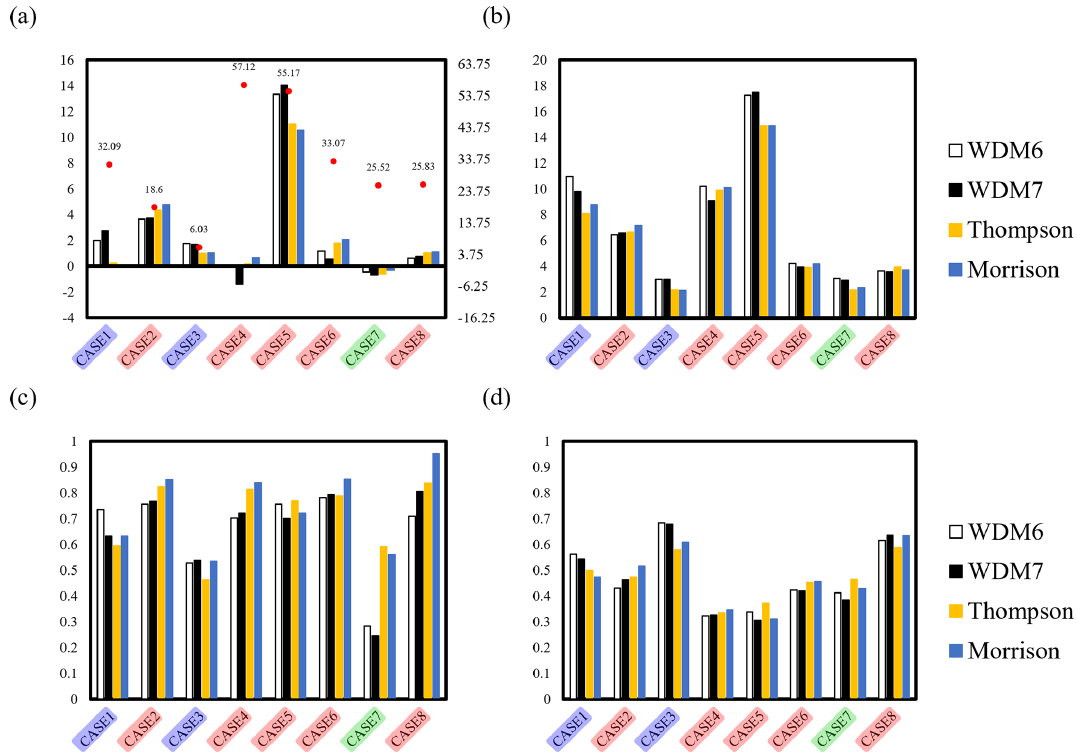
Figure 5. Statistical skill scores of bias, root-mean-square error (RMSE), probability of detection (POD), and false alarm ratio (FAR) for the simulated precipitation with respect to the AWS observation. The units of bias and RMSE shown in (a) and (b) are given in millimeters. White, black, yellow, and blue bars represent the results for the simulations with the WDM6, WDM7, Thompson, and Morrison schemes. The cold-low, warm-low, and air–sea interaction cases are shaded in blue, red, and green on the x axis. The total cumulative precipitation (mm) for each case obtained from the AWS (Table 1) is also noted in (a) using red dots that relate to the scale on the right-hand y